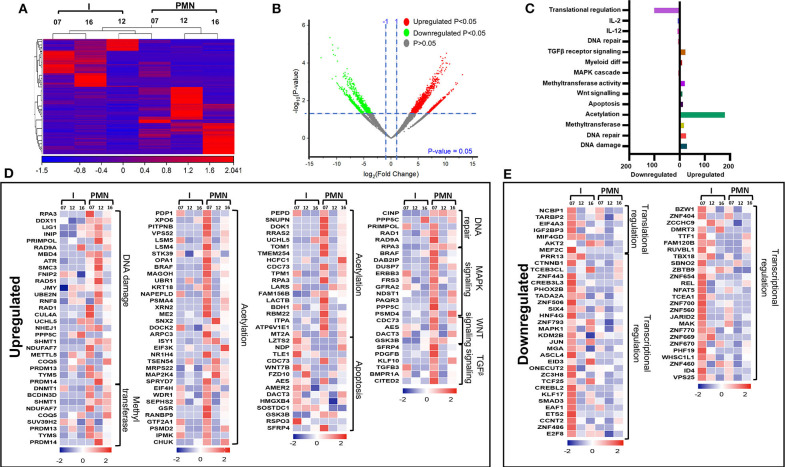
Comparative analyses of gene expression between PMN-MDSCs and I-MDSCs in the circulation of CRC patients. Hierarchical clustering of PMN-MDSCs and I-MDSCs from three patients (07, 12, and 16) on differentially expressed transcripts. Expression level of each gene is illustrated as a color code (A). Volcano plot illustrates the differential expression data, represented as log2 fold change on the x-axis, with the statistical impact on the y-axis. Fold changes with significant P values (>0.05) are highlighted in red (for upregulated genes) and green (for downregulated genes) (B). Functional categorizations for significantly upregulated and downregulated transcripts were analyzed on DAVID platform. Bar diagram illustrates the percentage of genes in each functional category (C). Heat maps show the Z score of the upregulated (D) and downregulated (E) transcripts in PMN-MDSCs, compared with I-MDSCs, based on their functional categorization.